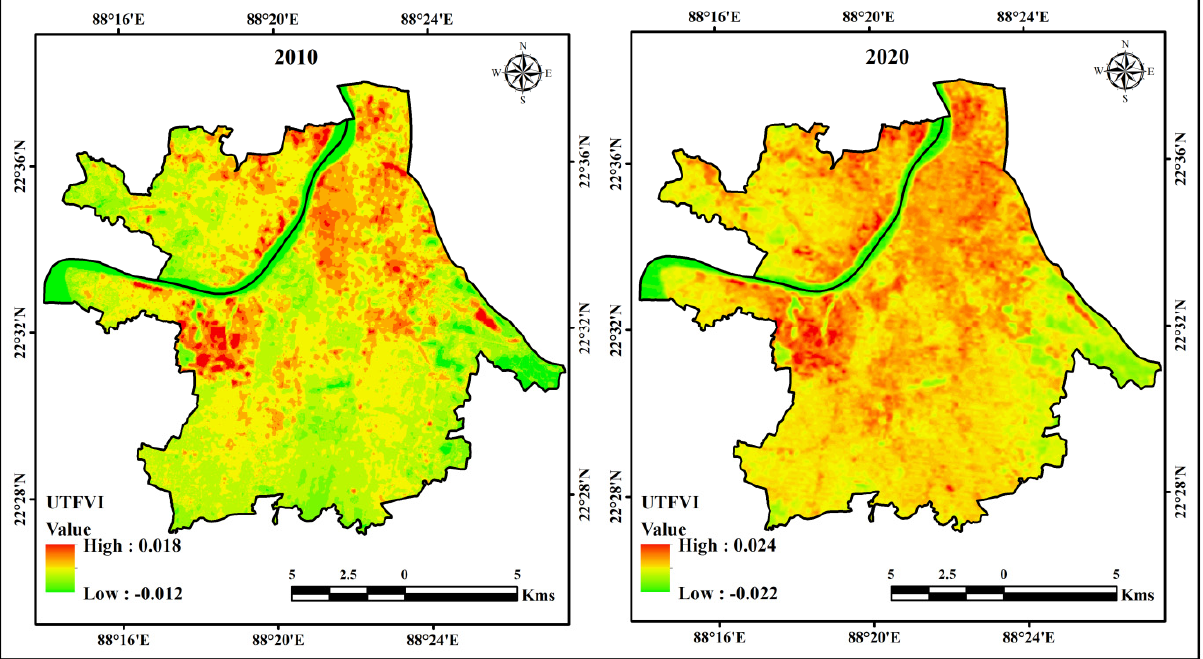
Figure 14. Urban thermal field variation index (UTFVI) variation in 2010 and 2020 for West Bengal (Kolkata and Howrah).